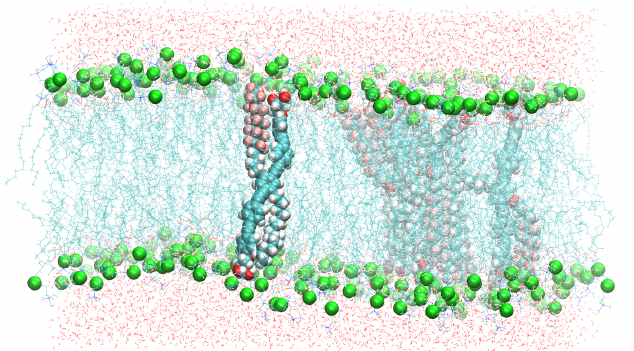
Figure 9. A snapshot of the simulated system containing six B16/10 molecules, 288 dipalmitoylphosphatidylcholine (DPPC) molecules, and 8756 water molecules. Periodic boundary conditions were used in all directions. Atoms of B16/10 molecules and phosphorus atoms of DPPC head groups are represented by solid spheres. Phosphorus atoms are green, fluorine atoms of B16/10 side chains are pink, and carbon atoms are cyan. All the lipid tails of DPPC are represented by cyan